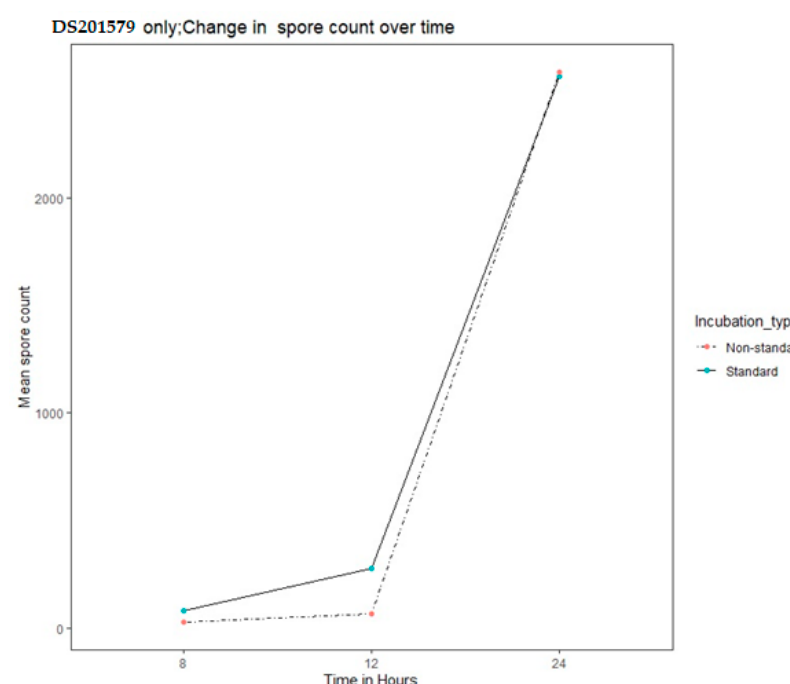
Figure A5. (A) : Change in cell counts for Bacillus anthracis Sterne strain under standard conditions and carcass conditions. (B) : Spore counts for Bacillus anthracis under standard conditions and carcass conditions. (C) : Change in cell counts for Bacillus anthracis DS201579 strain under standard conditions and carcass conditions. (D) : Change in spore counts for Bacillus anthracis Sterne strain under standard conditions and carcass conditions. (E) : Change in spore counts for Bacillus anthracis DS201579 strain under standard conditions and carcass conditions.